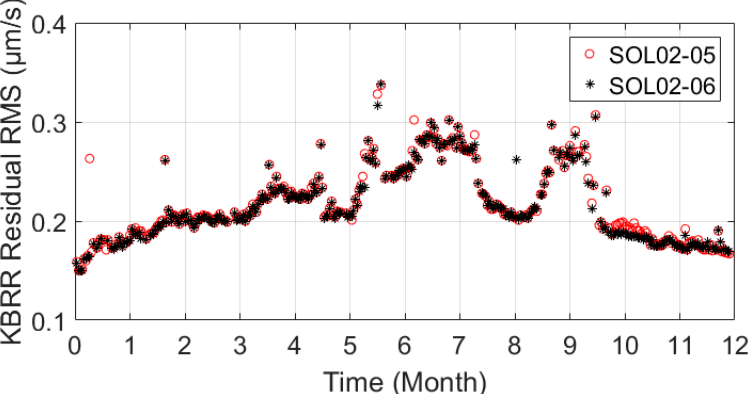
Figure 3. Daily RMS of KBRR post-fit residuals calculated using 2006 data and AOD1B RL05 and RL06 models, which are represented as SOL02-05 and SOL02-06, respectively.